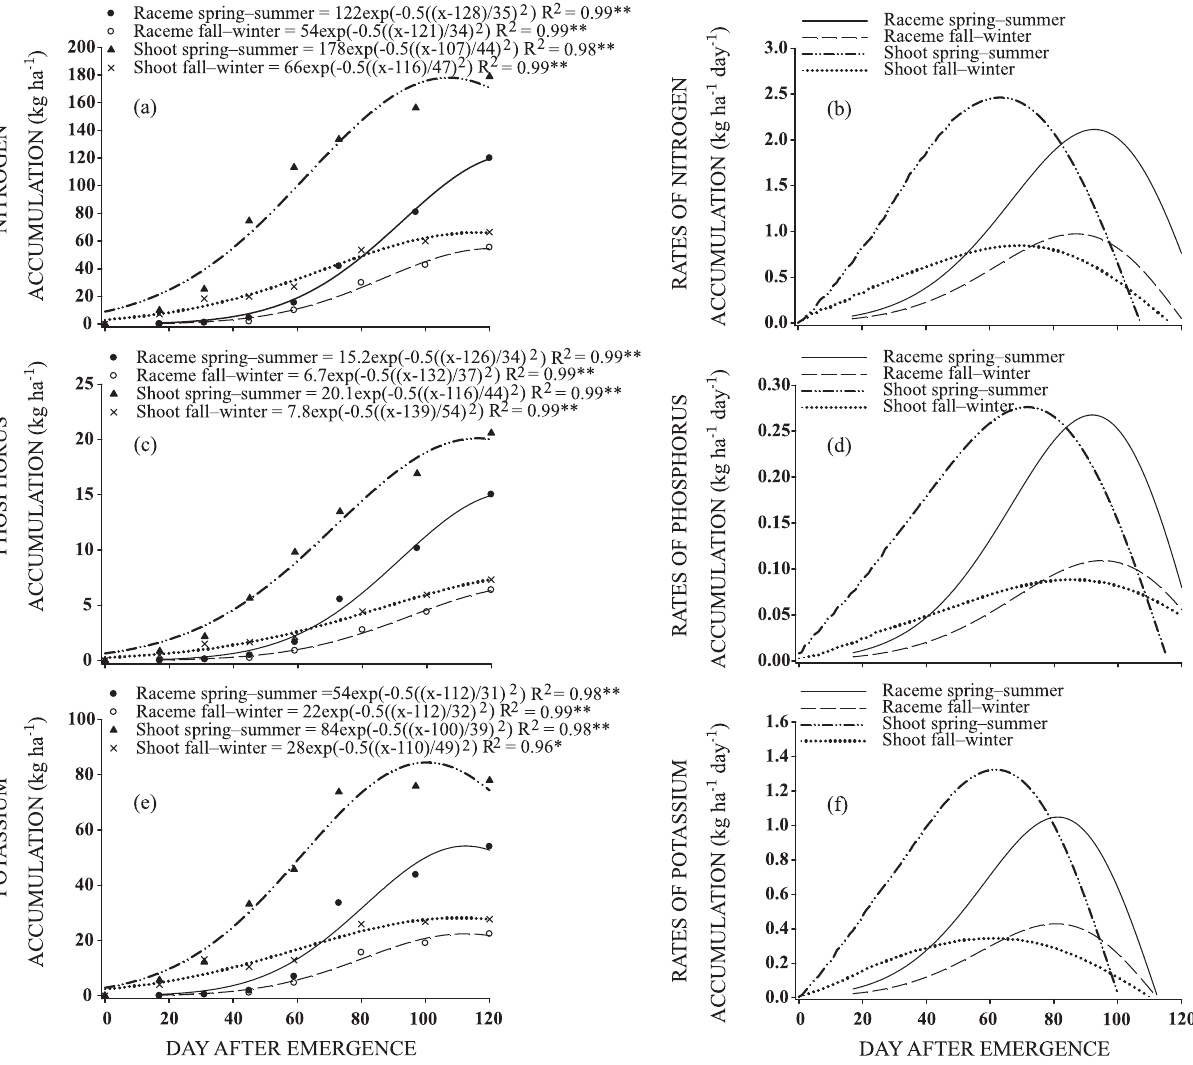
Figure 3. accumulation and accumulation rates of nitrogen (a and b), phosphorus (c and d) and potas- sium (e and f) in racemes and shoot of the castor bean hybrid Lyra in the 2005/2006 spring-summer and 2006 fall-winter growing seasons. ** and * are: significant at p ≤ 0.01 and p ≤ 0.05 by the F